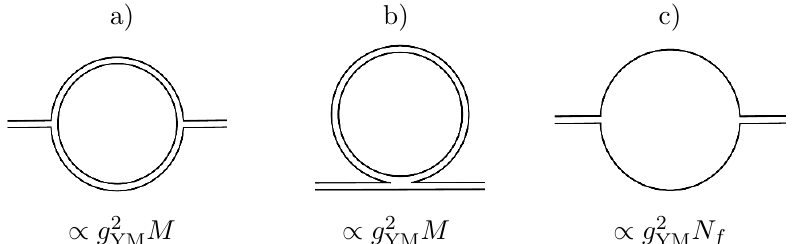
Figure 2 . 1-loop diagrams contributing to the real part of the gluon polarization tensor in a non- Abelian gauge theory together with their relative sizes given in terms of the gauge coupling g YM , number of colors M and the number of (cid:13)avors N f . a) gluon loop, b) gluon tadpole, c) fermion loop.